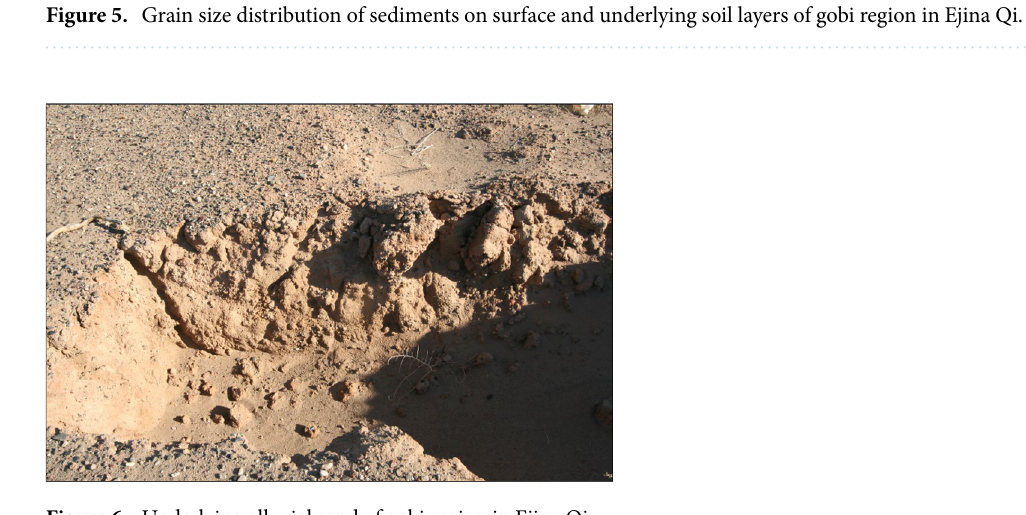
Figure 6. Underlying alluvial sand of gobi region in Ejina